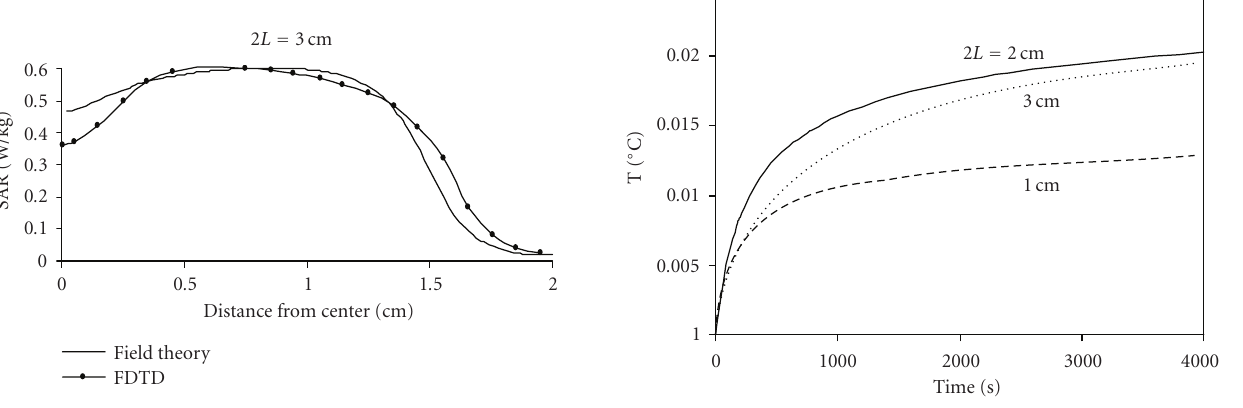
Figure 5: SAR at surface of the tissue for the 3cm total length an- tenna.